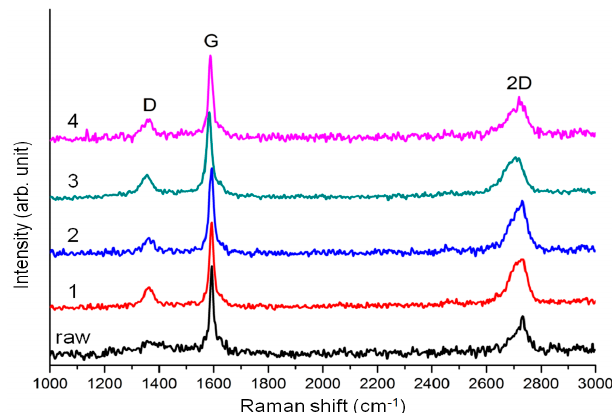
Figure 7. Raman spectra for supernatant solution of HOPG dispersions obtained from pristine HOPG (M-25, raw ), HOPG with PTFEMA 66 - b -PVP 41 ( 1 ), PTFEMA 66 - b -PVP 205 ( 2 ), PTFEMA 136 - b -PVP 31 ( 3 ), and PTFEMA 136 - b -PVP 194 ( 4 ). Table 2. I 2D / I G and I D / I G values from Raman spectra for monolayer graphene, graphite, graphene oxide, pristine HOPG (M-25, raw ), HOPG with PTFEMA 66 - b -PVP 41 ( 1 ), PTFEMA 66 - b -PVP 205 ( 2 ),